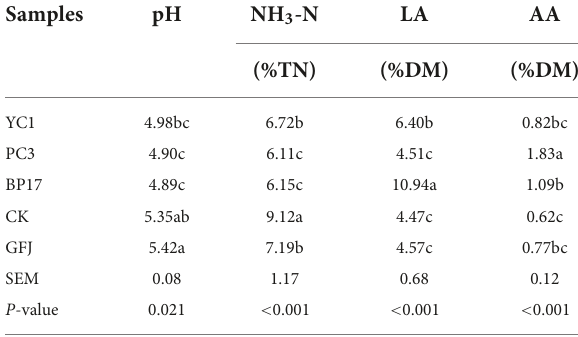
TABLE 4 The fermentation quality of paper mulberry